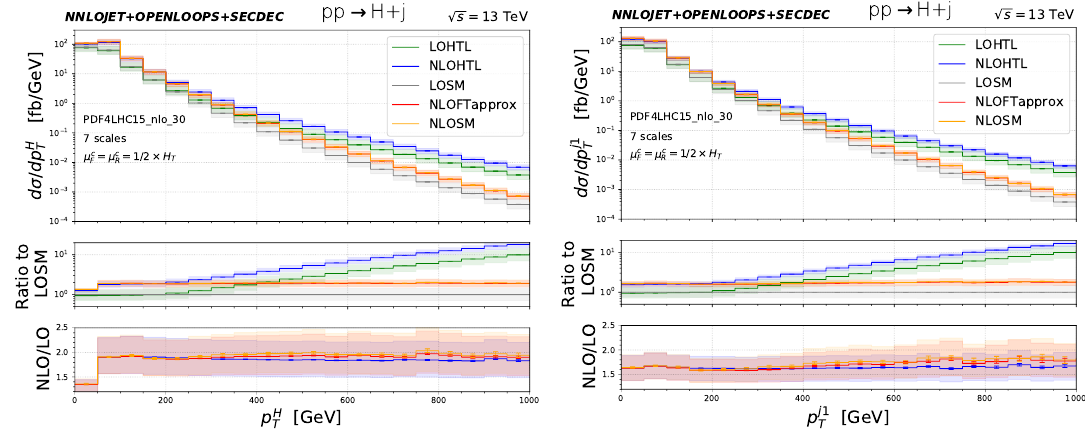
Figure 2 . Transverse momentum distribution of the Higgs (left) and the hardest jet (right) in H+ jet production. We show LO predictions in the full SM (LOSM, magenta) and the HTL (LOHTL, green) as well as NLO predictions in the HTL (NLOHTL, blue), the FT approx (NLOFTapprox, red) and the full SM (NLOSM, orange). The upper panel shows absolute predictions. The first ratio plot shows corrections with respect to LOSM, while the second ratio plot shows NLO corrections normalised to the respective LO prediction, i.e. NLOHTL/LOHTL, NLOSM/LOSM, and NLOFTapprox/LOSM. Shaded bands correspond to scale variations. Error bars indicate integration